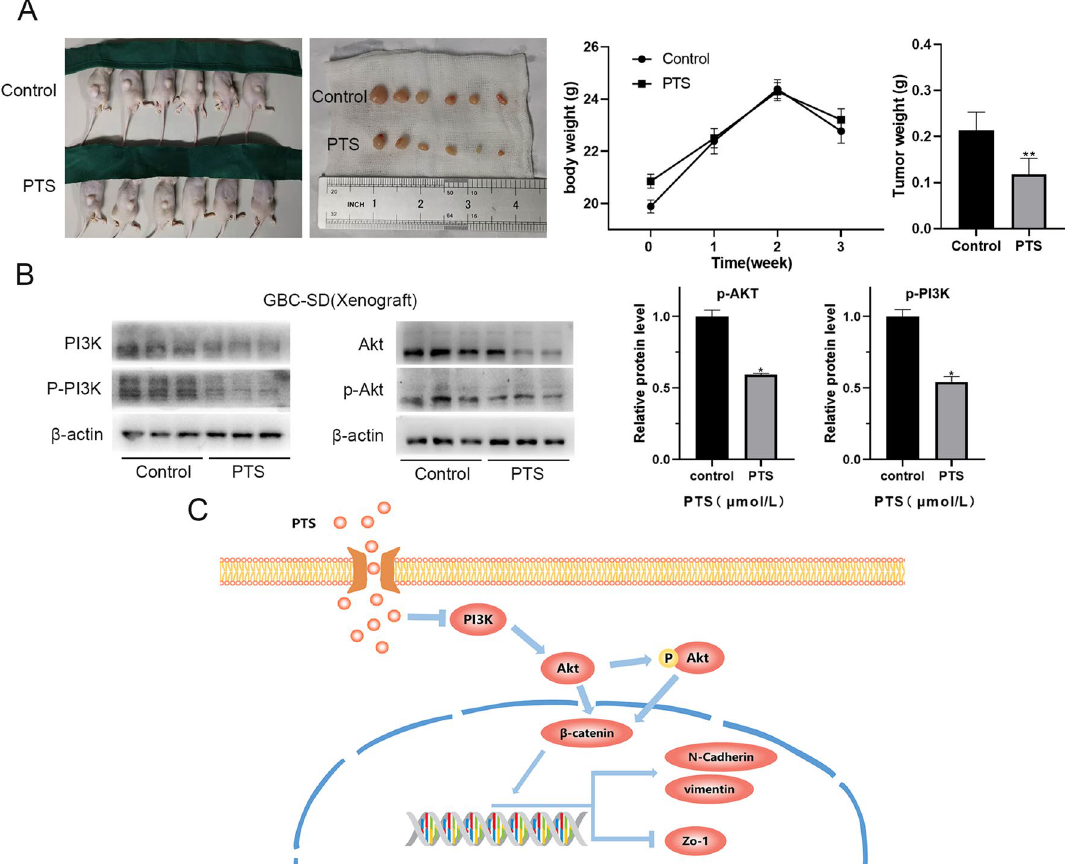
Figure 5. ( A ) The anti-tumor effect of PTS in the GBC-SD xenograft model. Body weights of GBC-SD xenograft-bearing mice after PTS treatment. Tumor weights and size of GBC-SD xenografts treated with PTS. ( B ) Expression of PI3K, p-PI3K, Akt and p-Akt protein in GBC-SD xenografts. ( C ) A proposed model for how PI3K/Akt/β-catenin signaling mediates EMT in GBC-SD cells. * P < 0.05; ** P < 0.01, compared with the control